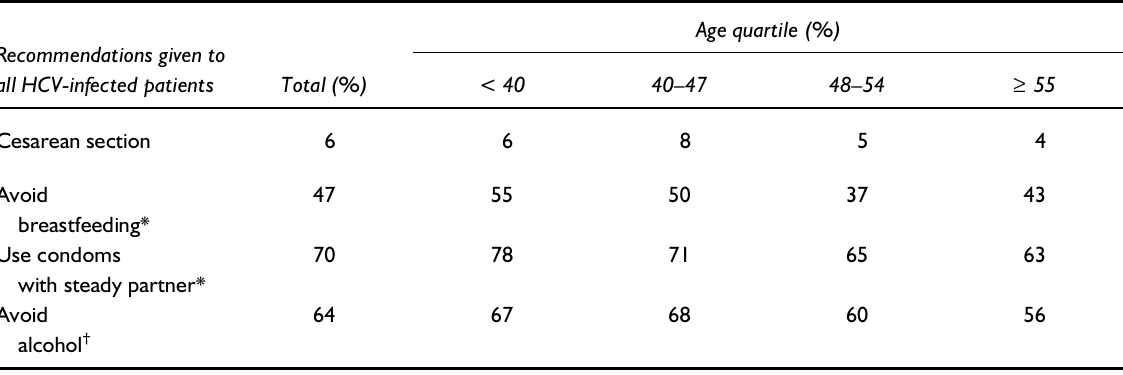
Table 3 Percentage of providers who made specific recommendations to patients with hepatitis C virus infection, according to provider age